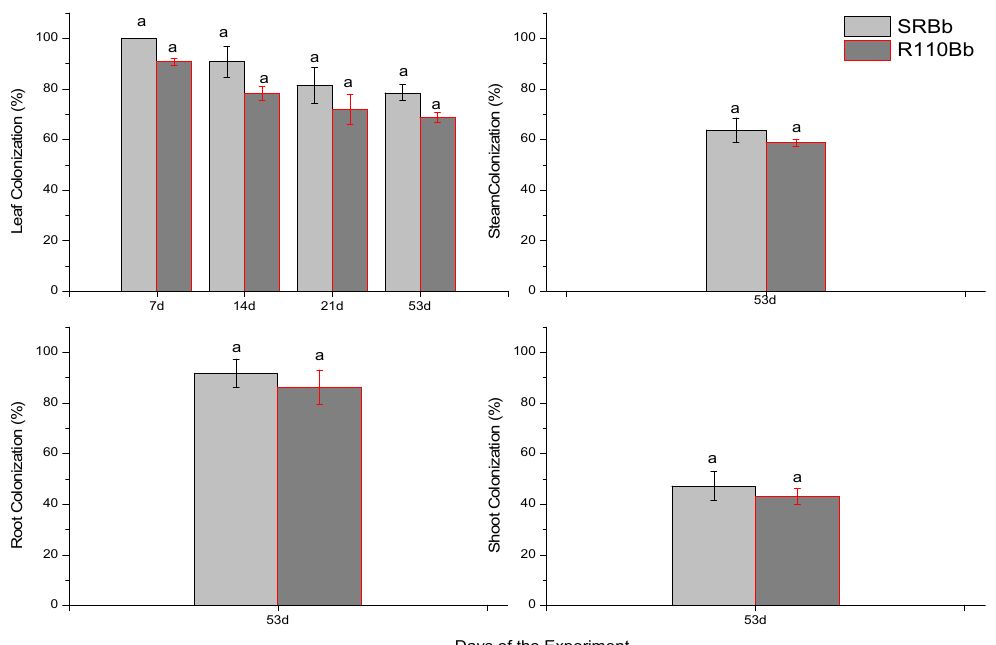
Figure 3. Mean ( ± sd; n = 50) colonization of V. vinifera leaf parts by B. bassiana , at 7 days, 14 days, 21 days, and 53 days after irrigation. Mean ( ± sd; n = 50) colonization of Stem, Shoot and Roots of V. vinifera by B. bassiana , at 53 days after irrigation. Mean ± sd values of different plant groups (SR or R110) with the same letter are not significantly different (Bonferroni’s test: p < 0.05). SRBb: self-rooted grapevines infested with B.bassiana , R110Bb: R110 rootstocks grapevines infested with B.bassiana .